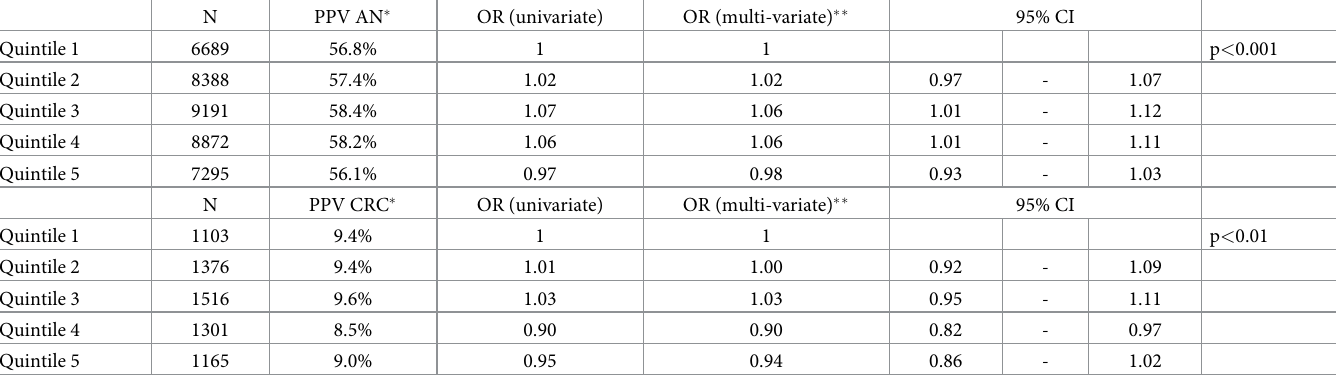
Table 3. The positive predictive value (PPV) of FIT for advanced neoplasia (AN) and colorectal cancer (CRC) in each SES quintile, with the univariate and multivar- iate odds ratio (OR) and 95%